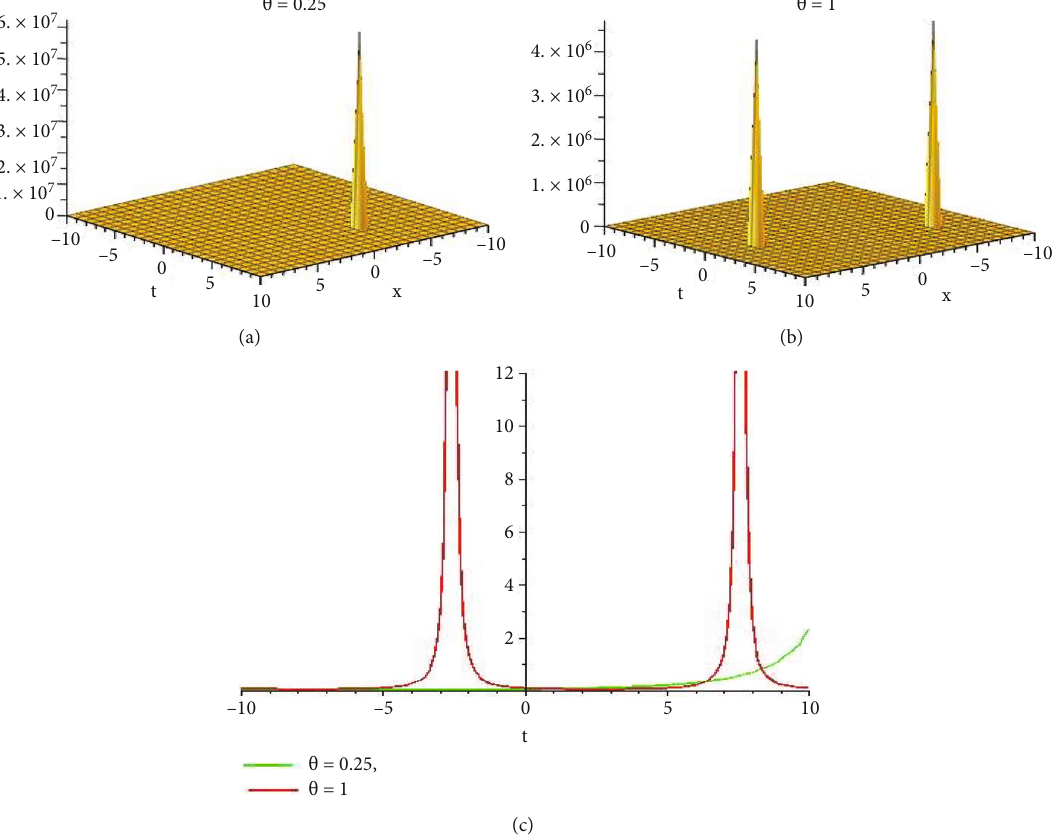
, t Þ . (a, b) 3D plot and (c) 2D combined plot for x = 1 Figure 13: Dynamical behavior of function solution of u 20,21 ð x ffiffiffiffiffiffiffiffiffiffiffiffiffiffiffiffiffiffiffiffiffiffiffiffiffiffiffiffiffi p − 16 β λμ n 3 + 1 / β λμ n 2 Þ x + n ð t θ /